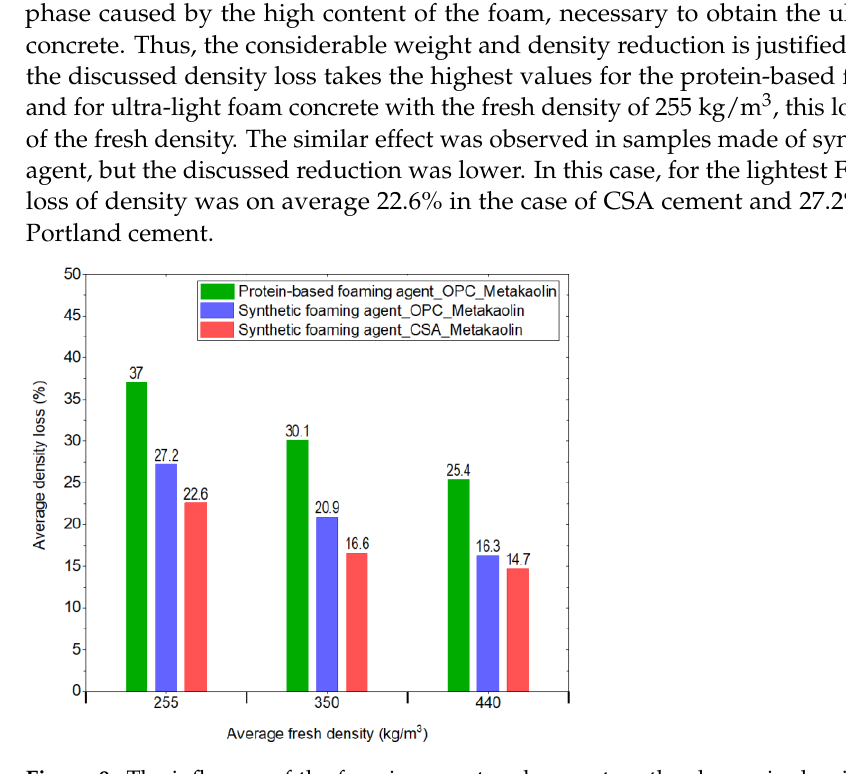
Figure 9. The influence of the foaming agent and cement on the change in density from fresh to air-dry state.